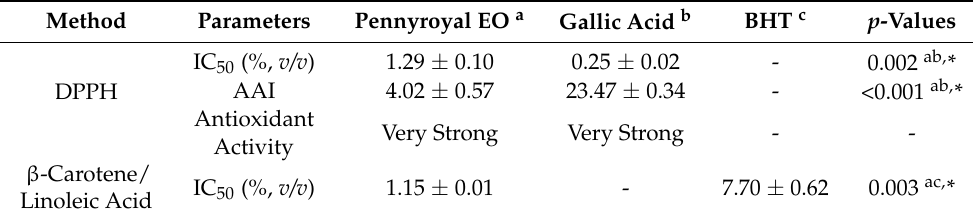
Table 2. Antioxidant properties of pennyroyal EO.